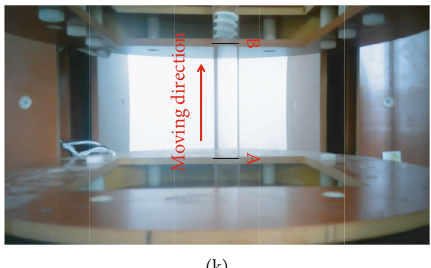
Figure 15: Hyperspatial motion. (a – c) The forward horizontal movement of the X -axis; (d, e) the reverse horizontal movement of the X -axis; (g, h) locomotion direction is 70 ° Y -axis; (i – k) the vertical movement of the Z